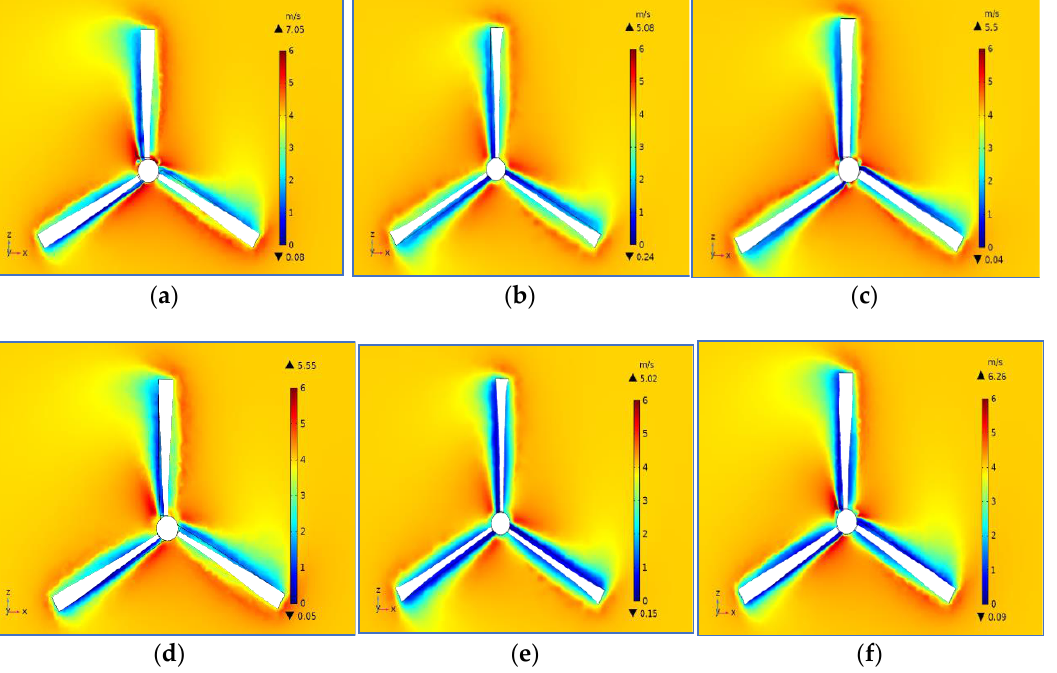
( d ) Figure 12. Negative suction pressure and positive pressure distributions for ( a , c ) rectangular blades and ( b , d ) tapered blade configurations. 4.2. Twist Distribution Effect on SSWT Performance In this section, the influence of twist angle distribution on the overall efficiency of the SSWT is explored. The different linear and nonlinear twist distributions that are depicted in Figure 3 are considered. The details of each twist distribution are provided in Section 2.1 and a summary of the differences between each configuration is provided in Table 2.